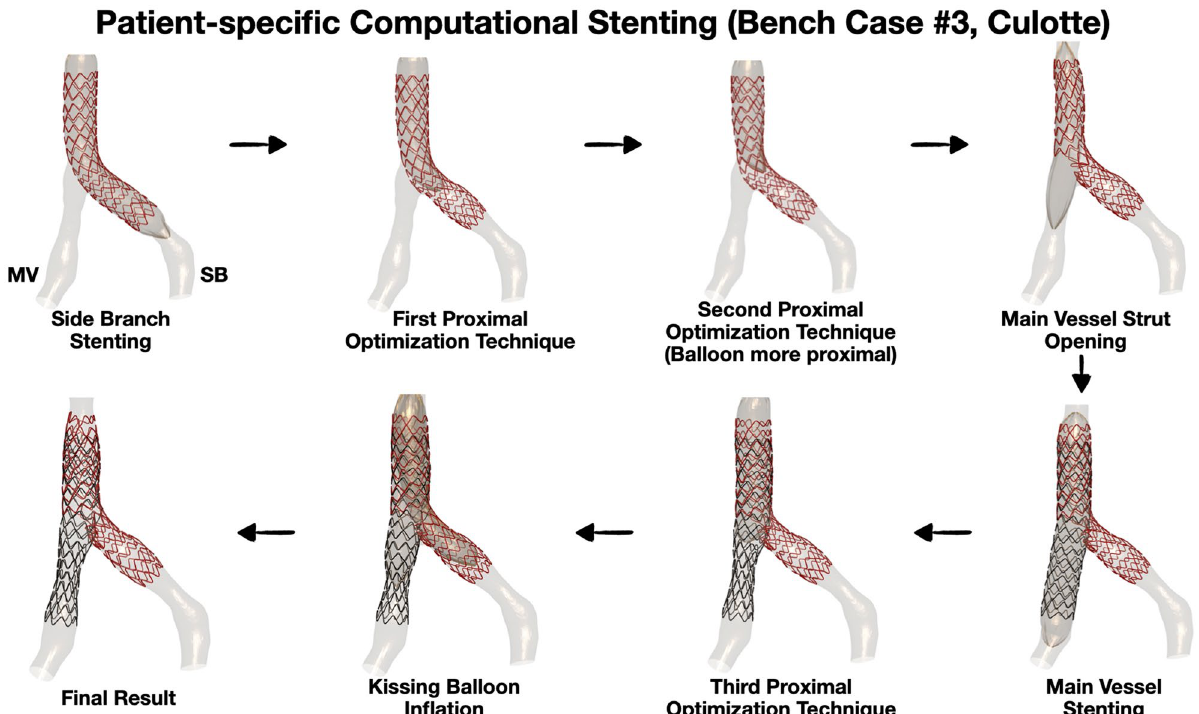
Figure 2. Representative computational simulation of a bench stenting case. A patient-specific silicone bifurcation geometry was stented on the bench with the culotte technique. We faithfully replicated computationally all the steps of the stenting procedure using the same bifurcation geometry and stent/balloon designs; SB side branch, MV main